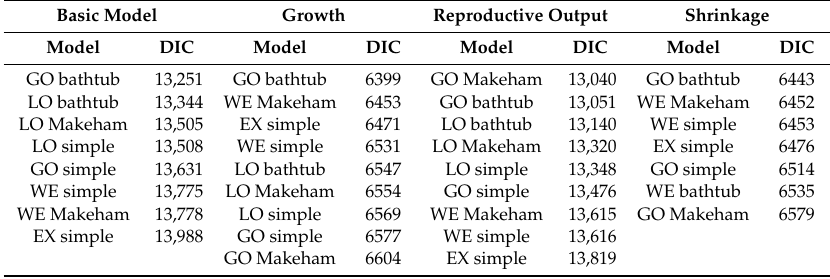
Table 1. DICs of all converging models when using only sites (basic model) and when including growth, reproductive output and shrinkage as covariate.